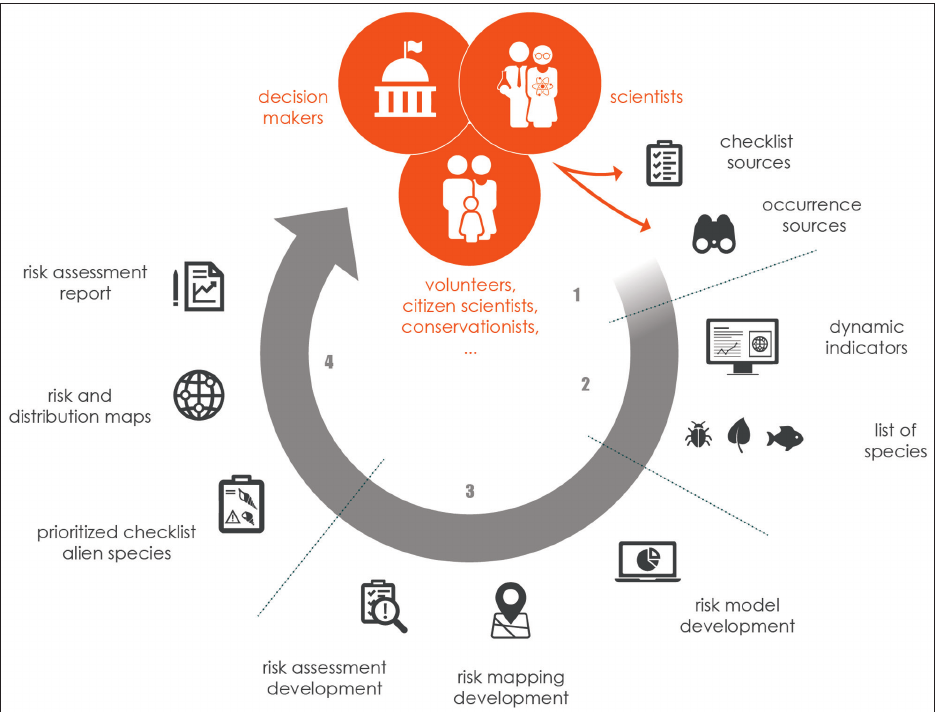
Figure 1: Citizens and biodiversity scientists both are providers of invasive species data and users of the informa- tion created from them. Open data workflows can be created whereby contributors of data produce the aggregated knowledge about the organisms that interest them. Products such as maps, indicators, and predictive models aim to support the data providers, while also creating policy relevant information. In the Belgian TrIAS project, a cycle is envisaged that starts with data publication and continues with the generation of aggregate indicators, maps, models, and risk assessments. All this analysis results in publications aimed both at the contributors of data and policy sup- port. This motivates citizens and scientists alike and creates a cycle supporting knowledge creation. The participants contribute most to the information cycle, but because the data are openly licenced, information can be spun off for use in policy. However, policy-makers can contribute to this cycle in many ways, such as by sharing public data, by providing training, and by supporting the underlying